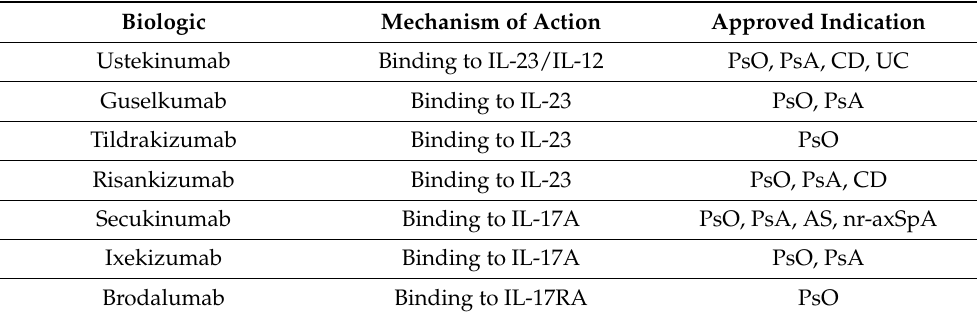
Table 3. Approved anti-IL23 and anti-IL-17 biologics for adult